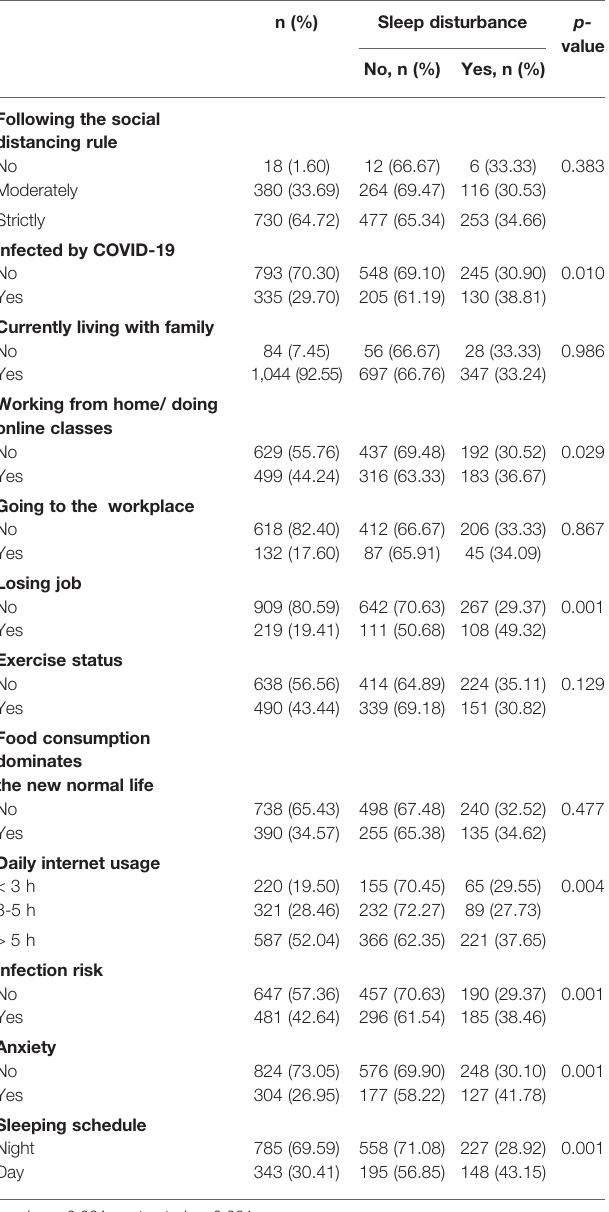
TABLE 3 | Distribution of sleep disturbance by respondent ’ s characteristics TABLE 4 | Determinant analysis of sleep disturbance: Results from a regarding COVID-19 and new normal life during the lockdown. multivariable logistic regression n (%) Sleep disturbance p-